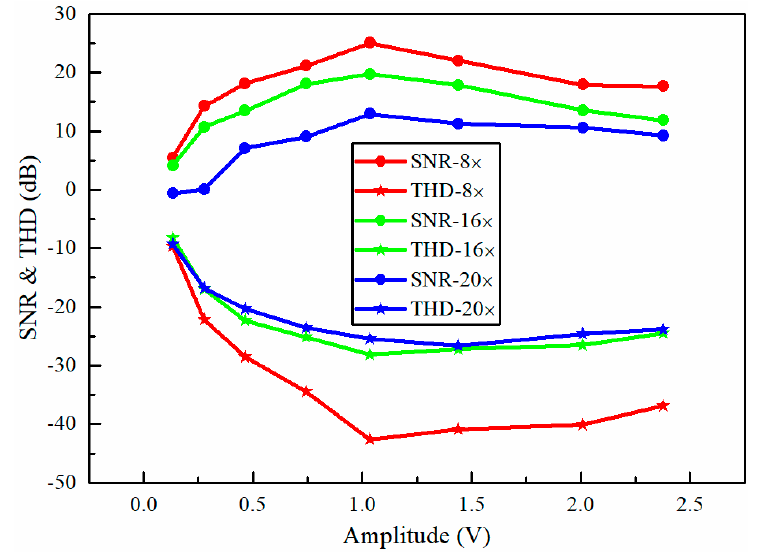
Figure 12. The dependence of the SNR (circle symbol) and THD (total harmonic distortion) (star symbol) of the recovered sinusoidal sound signal on the amplitude of the sinusoidal voltage applied to the loudspeaker at the different compressions of 8 × (red points), 16 × (green points), and 20 × (blue points). The frequency of the sinusoidal voltage applied to the loudspeaker is 150 Hz and the rate of CCD image recording is 100 Hz.